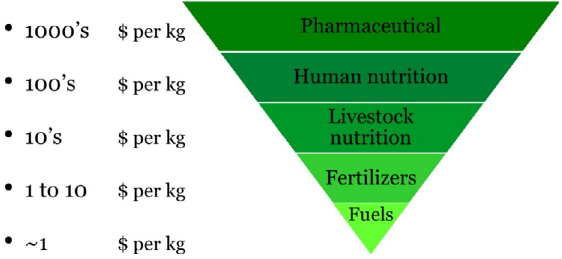
Fig. 1. Biomass revenue scales for different groups of products.